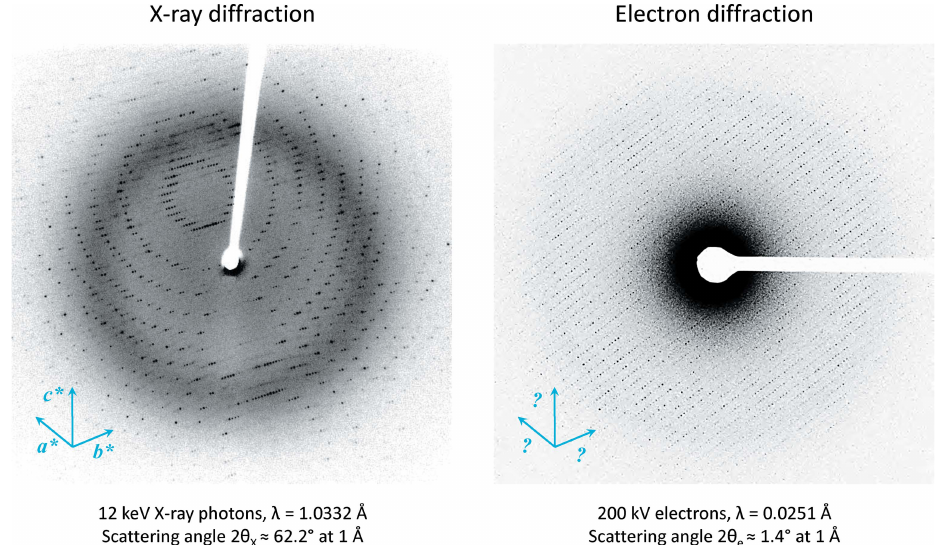
Figure 2 Differences between X-ray and electron diffraction. Diffraction patterns are shown for X-ray diffraction and MicroED. The much shorter wavelength of high-energy electrons means that the Ewald sphere construction is virtually flat. Indexing from a single diffraction frame is therefore not typically possible for electron diffraction, and a larger wedge of reciprocal space needs to be covered to find the unit-cell